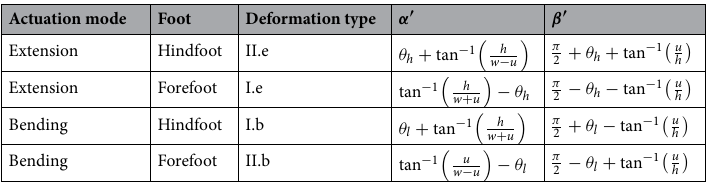
Table 3. Extended angle relations for